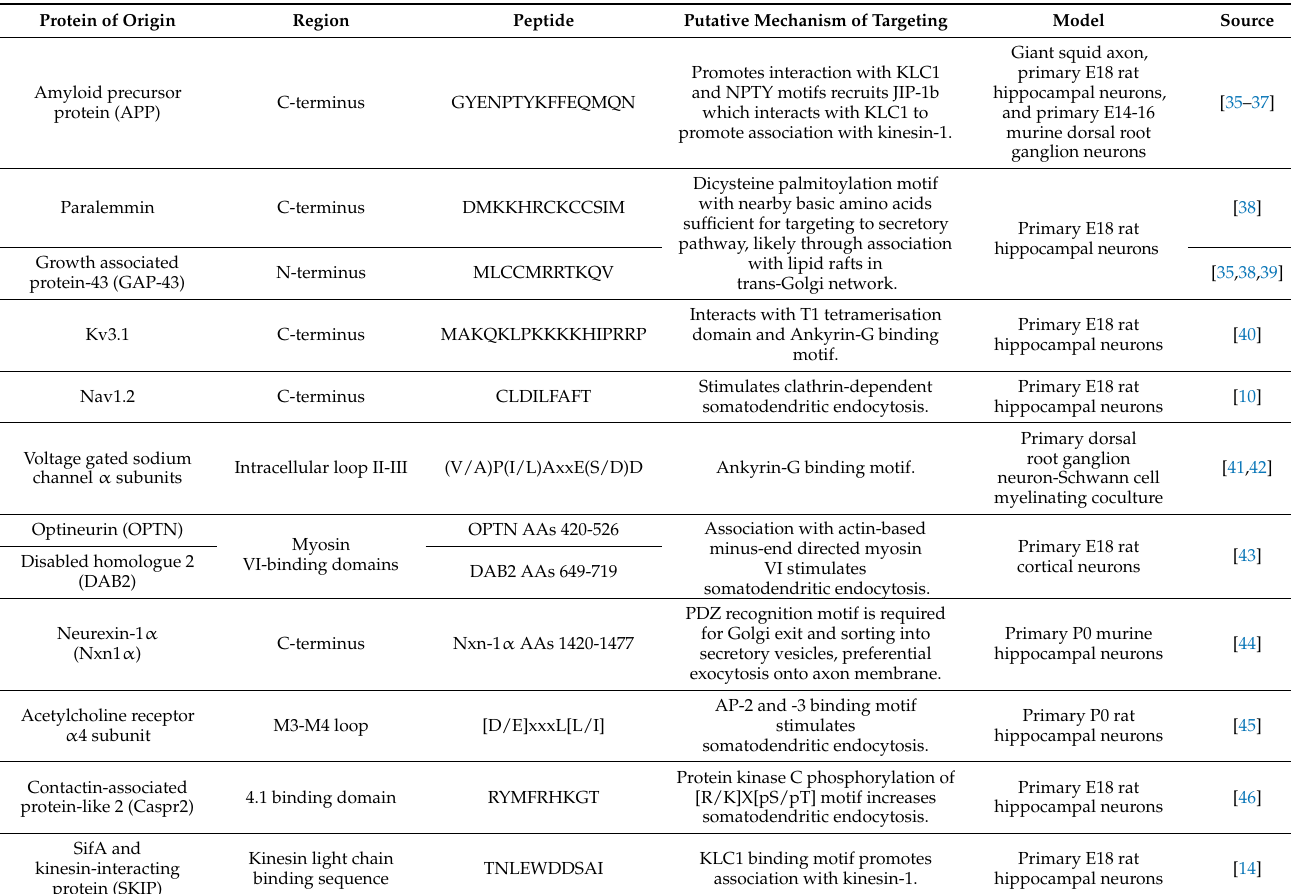
Table 1. Summary of previously identified and characterised axon-targeting motifs (ATMs). Examples of several ATMs characterised in the literature. The protein of origin, reported location and amino acid sequence of each ATM is given. Where possible, the putative targeting mechanism is also summarised alongside the model used to study the targeting